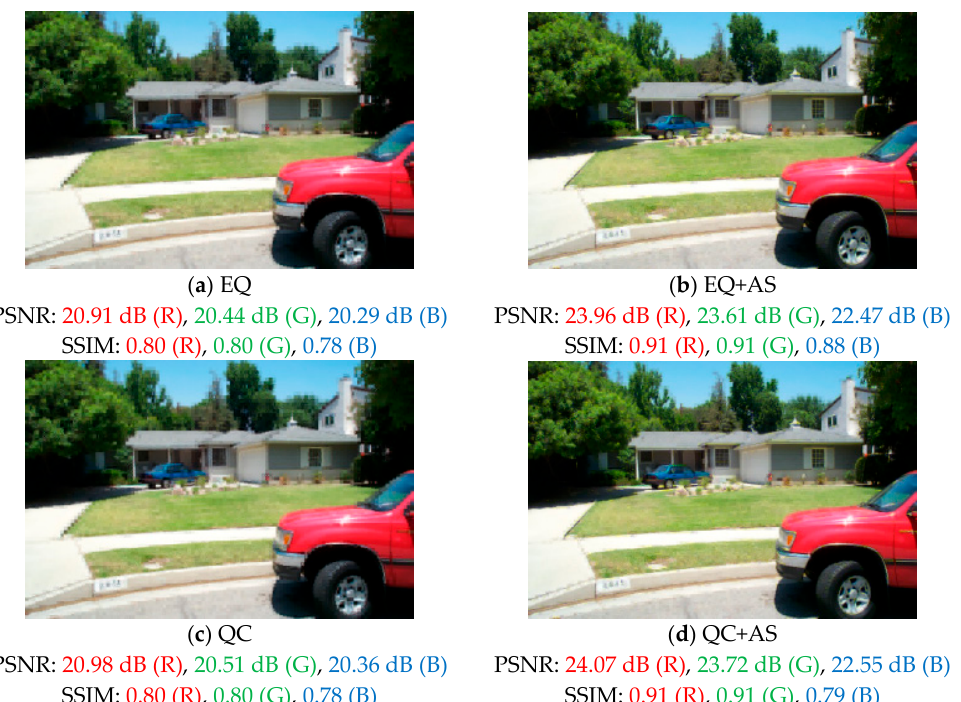
Figure 13. Reconstruction of BCS coefficients for the three color planes: ( a ) EQ only; ( b ) EQ + AS; ( c ) QC only; and ( d ) QC + AS.